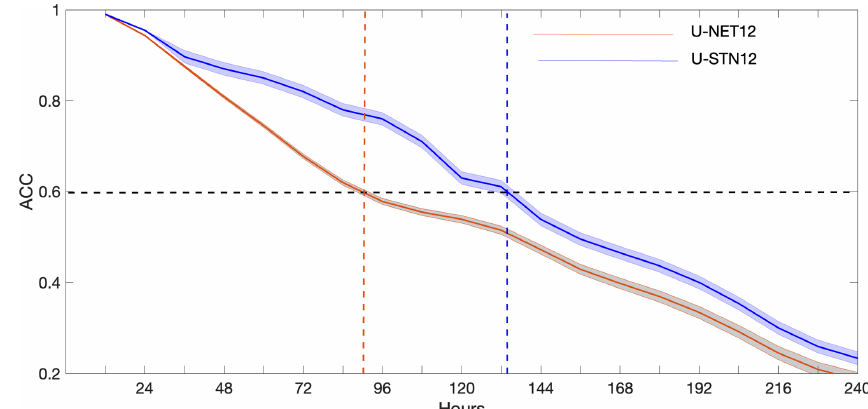
Figure 3. Anomaly correlation coefficient (ACC) calculated between Z500 anomalies of ERA5 and Z500 anomalies predicted using U- STN12 or U-NET12 from 30 noise-free, random initial conditions. The solid lines and the shading show the mean and the standard deviation over the 30 initial conditions.